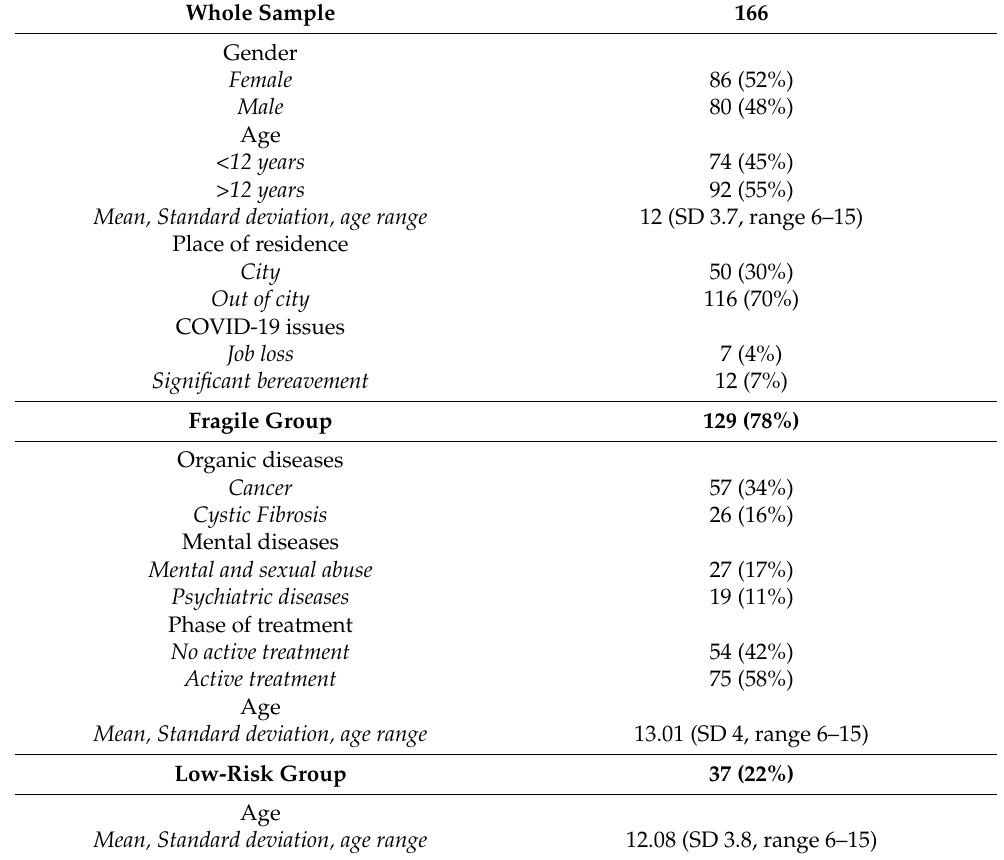
Table 1. Characteristics of the